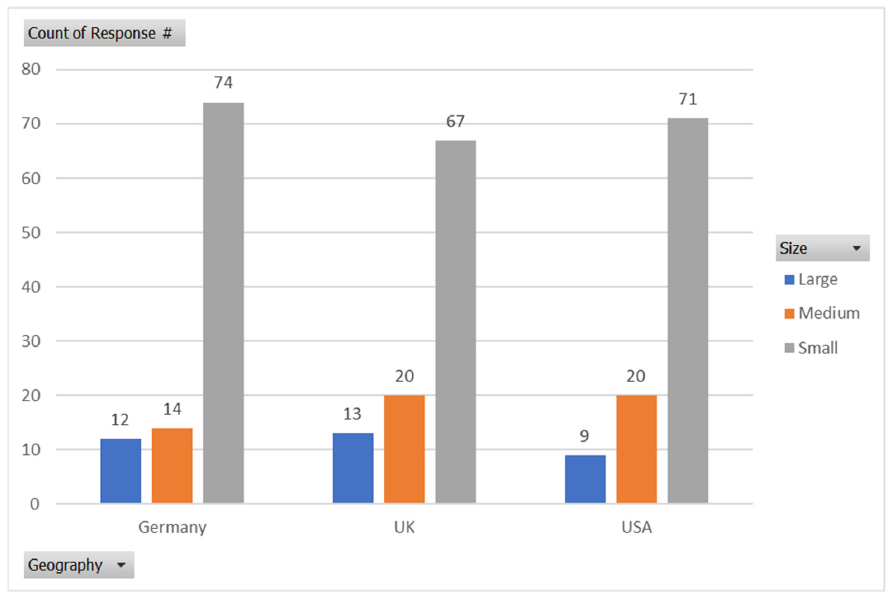
Figure 2. Size of the company by country.